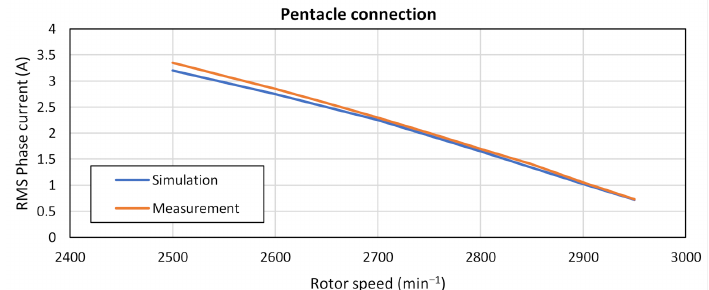
Figure 33. Dependence of phase a motor current on speed for the fault-free state in pentacle connec- tion.